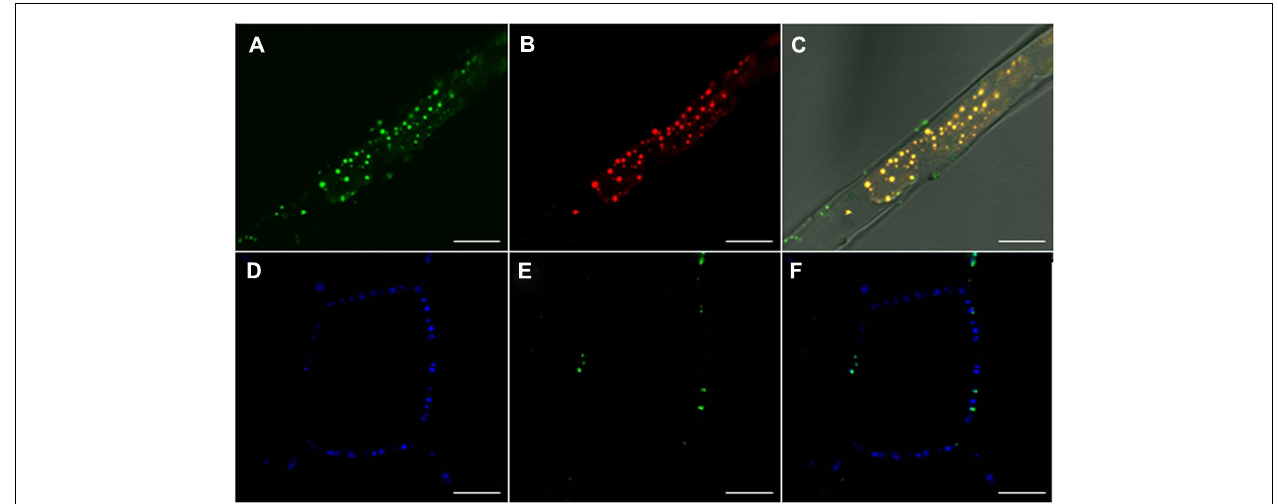
with LBs, except at the plasmamembrane, where GFP::Ole2 containing bodies are free of lipid. (D–F) Confocal images of leaf cells of Arabidopsis GFP::Ole2 lines showing PD-callose stained with aniline blue (D) , and the LB marker-protein GFP::Ole2 (E) . (F) Overlay shows that GFP::Ole2 has low expression in leaf cells, but co-localizes with callose at PD. Bars, 10